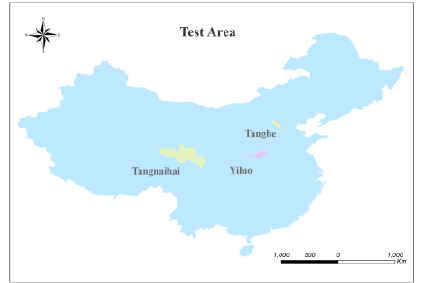
Figure 1. Locations of the three test